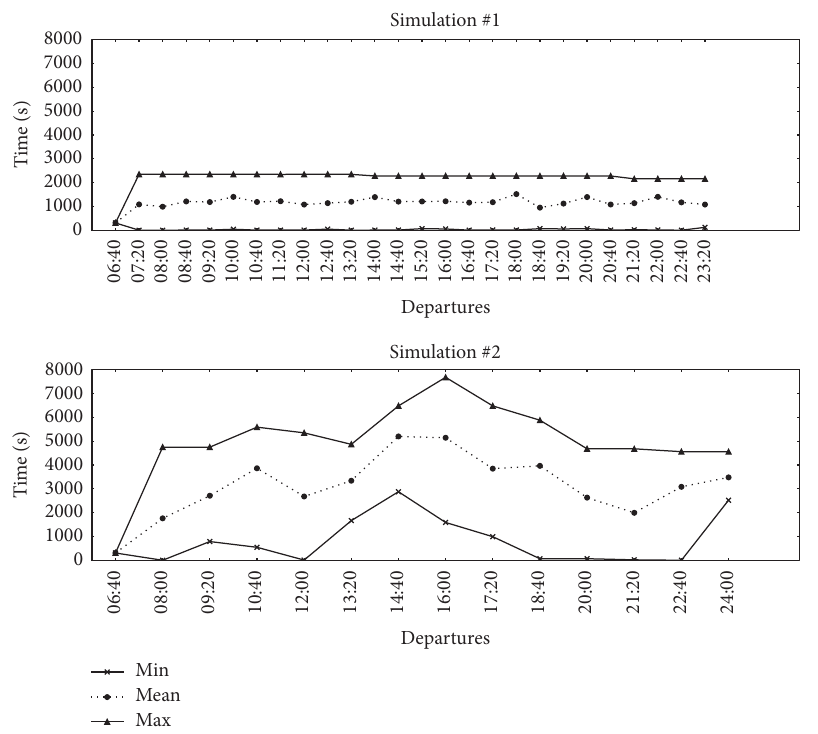
Figure 12: Statistics of waiting time for each